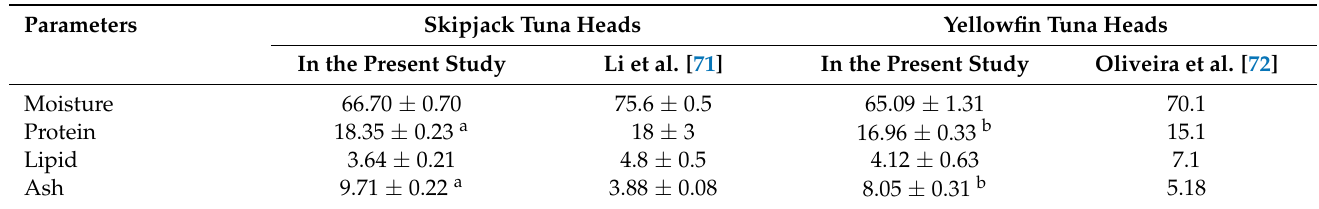
Table 1. Proximate composition of skipjack heads and yellowfin tuna heads (g/100 g fresh weight)